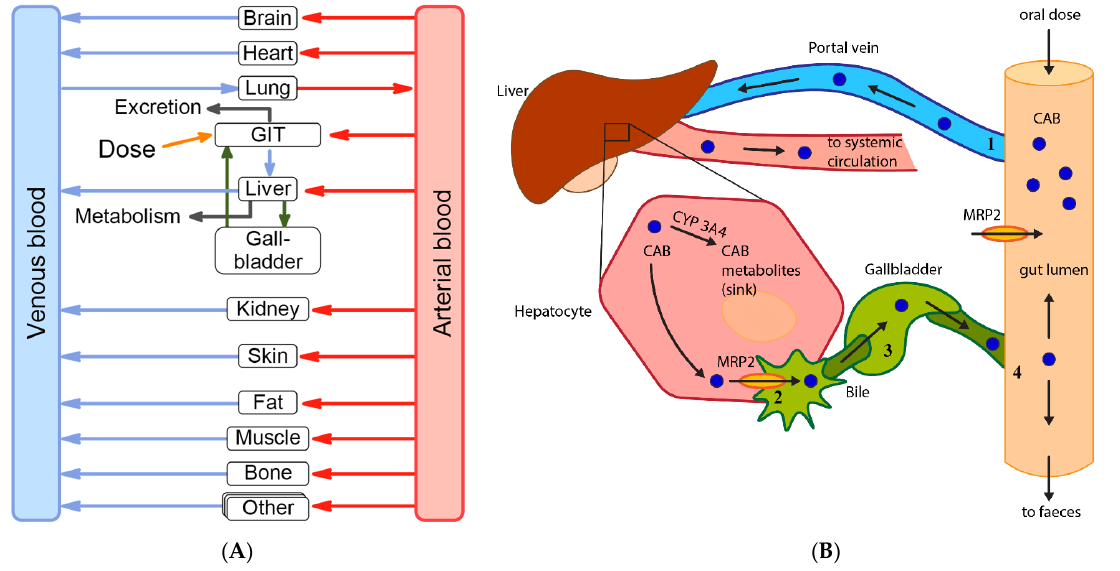
Figure 6. ( A ) Overview of the final PBPK model. Cabozantinib enters the PBPK model via oral administration to the